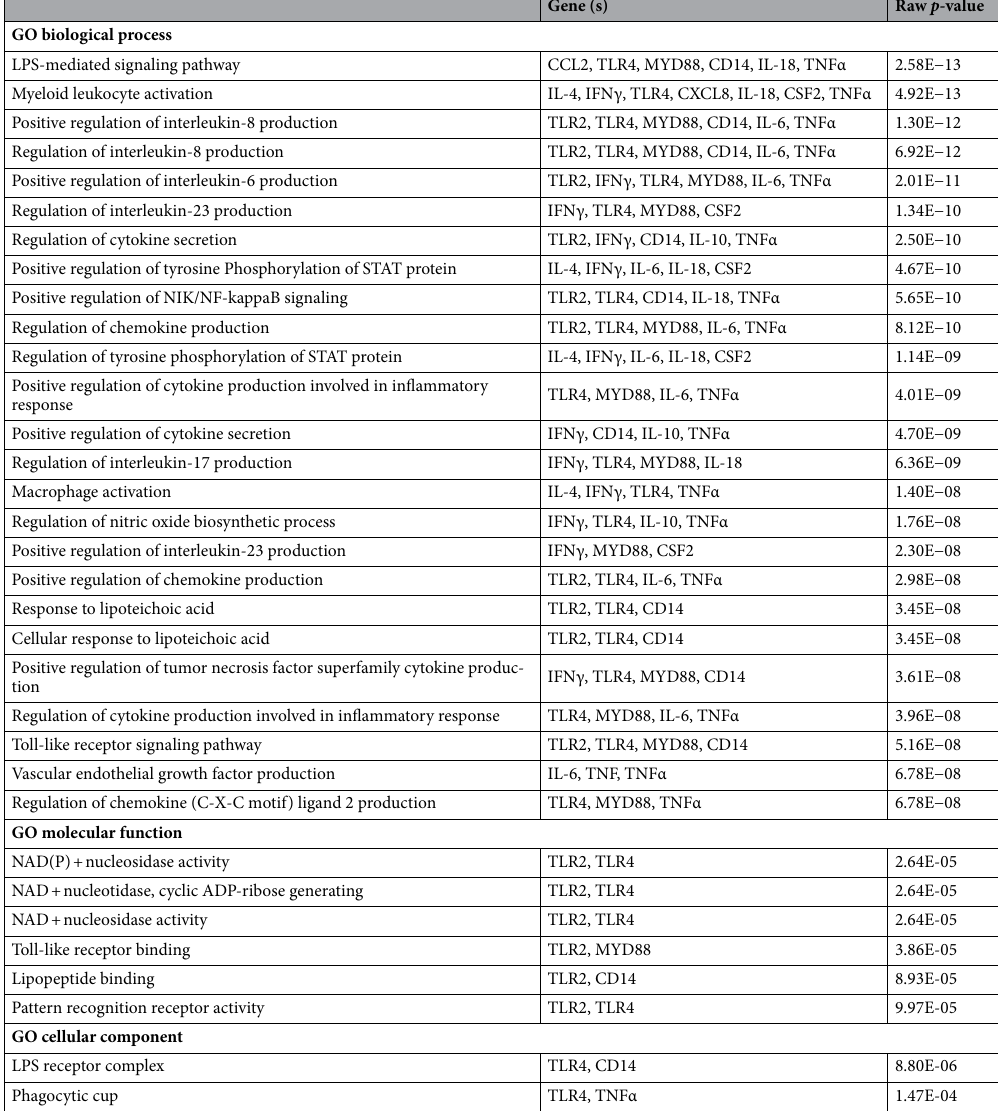
Table 4. Gene ontology biological processes, molecular functions, and cellular components of bovine mastitis target